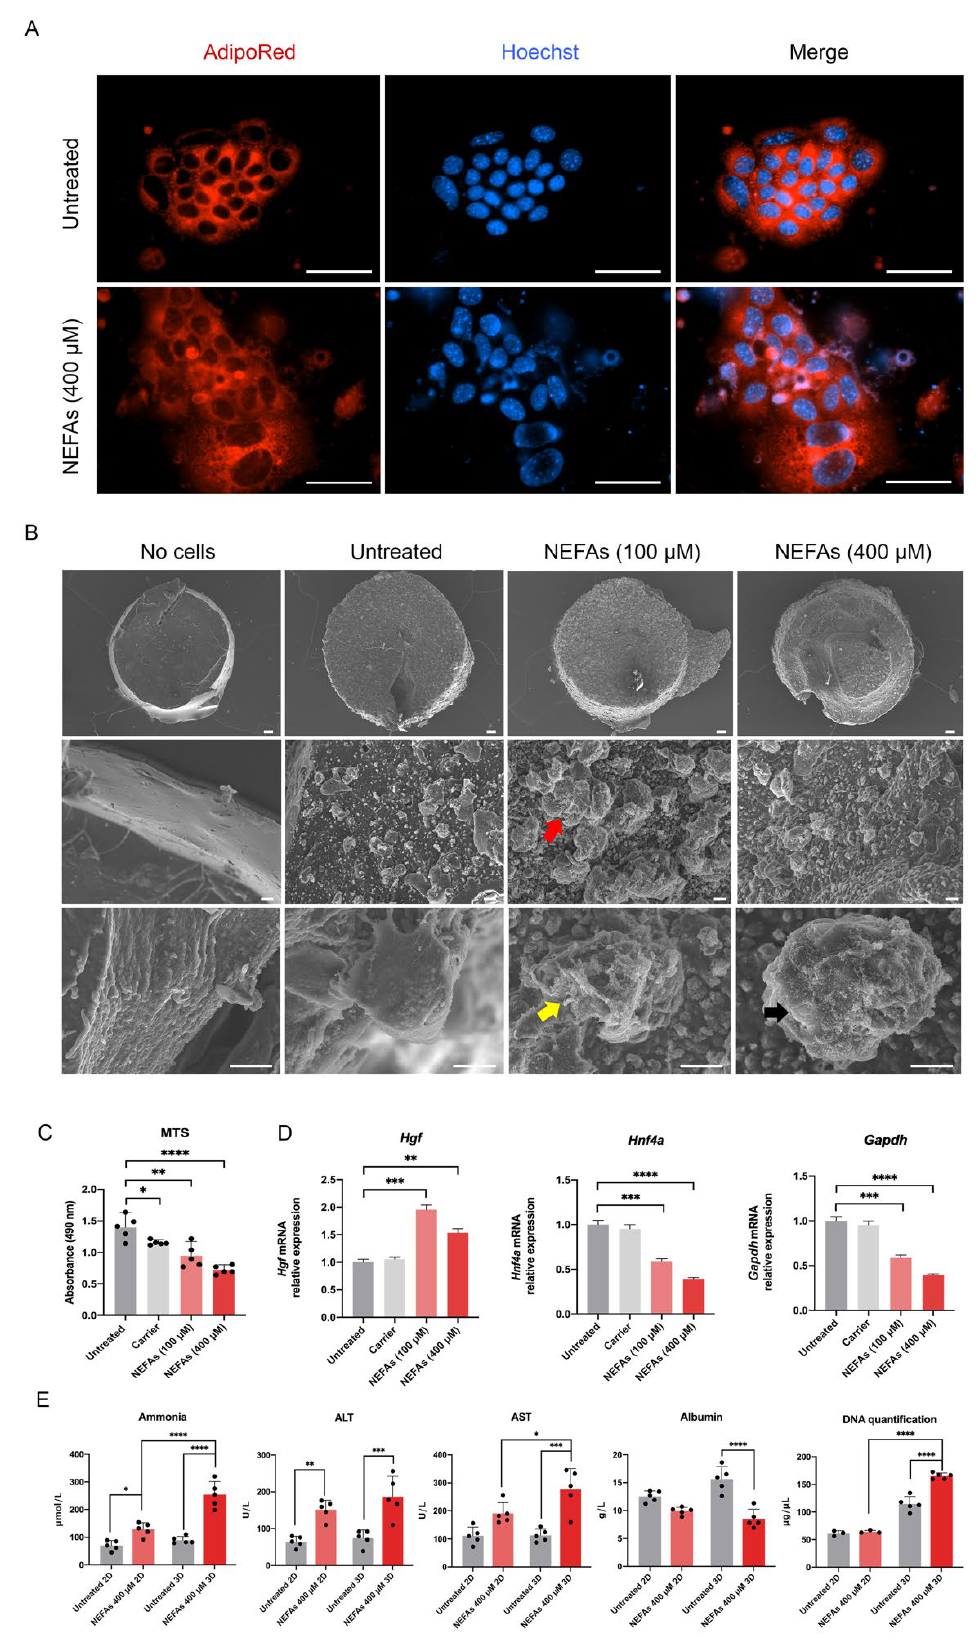
Figure 4. In vitro three-dimensional model of Non-alcoholic fatty liver. ( A ) Confocal images of lipid accumu- lation in NEFAs treated hepatocytes assessed by AdipoRed™ assay. Scale bar = 200 µ m. ( B )